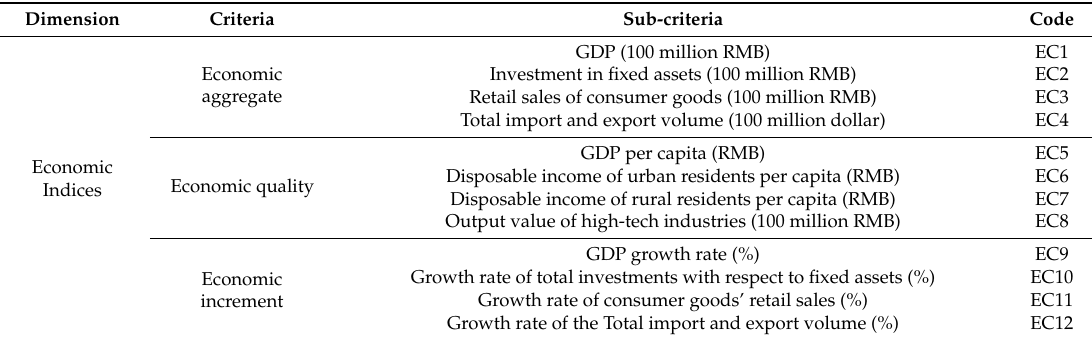
Table 1. Evaluation index system of urban